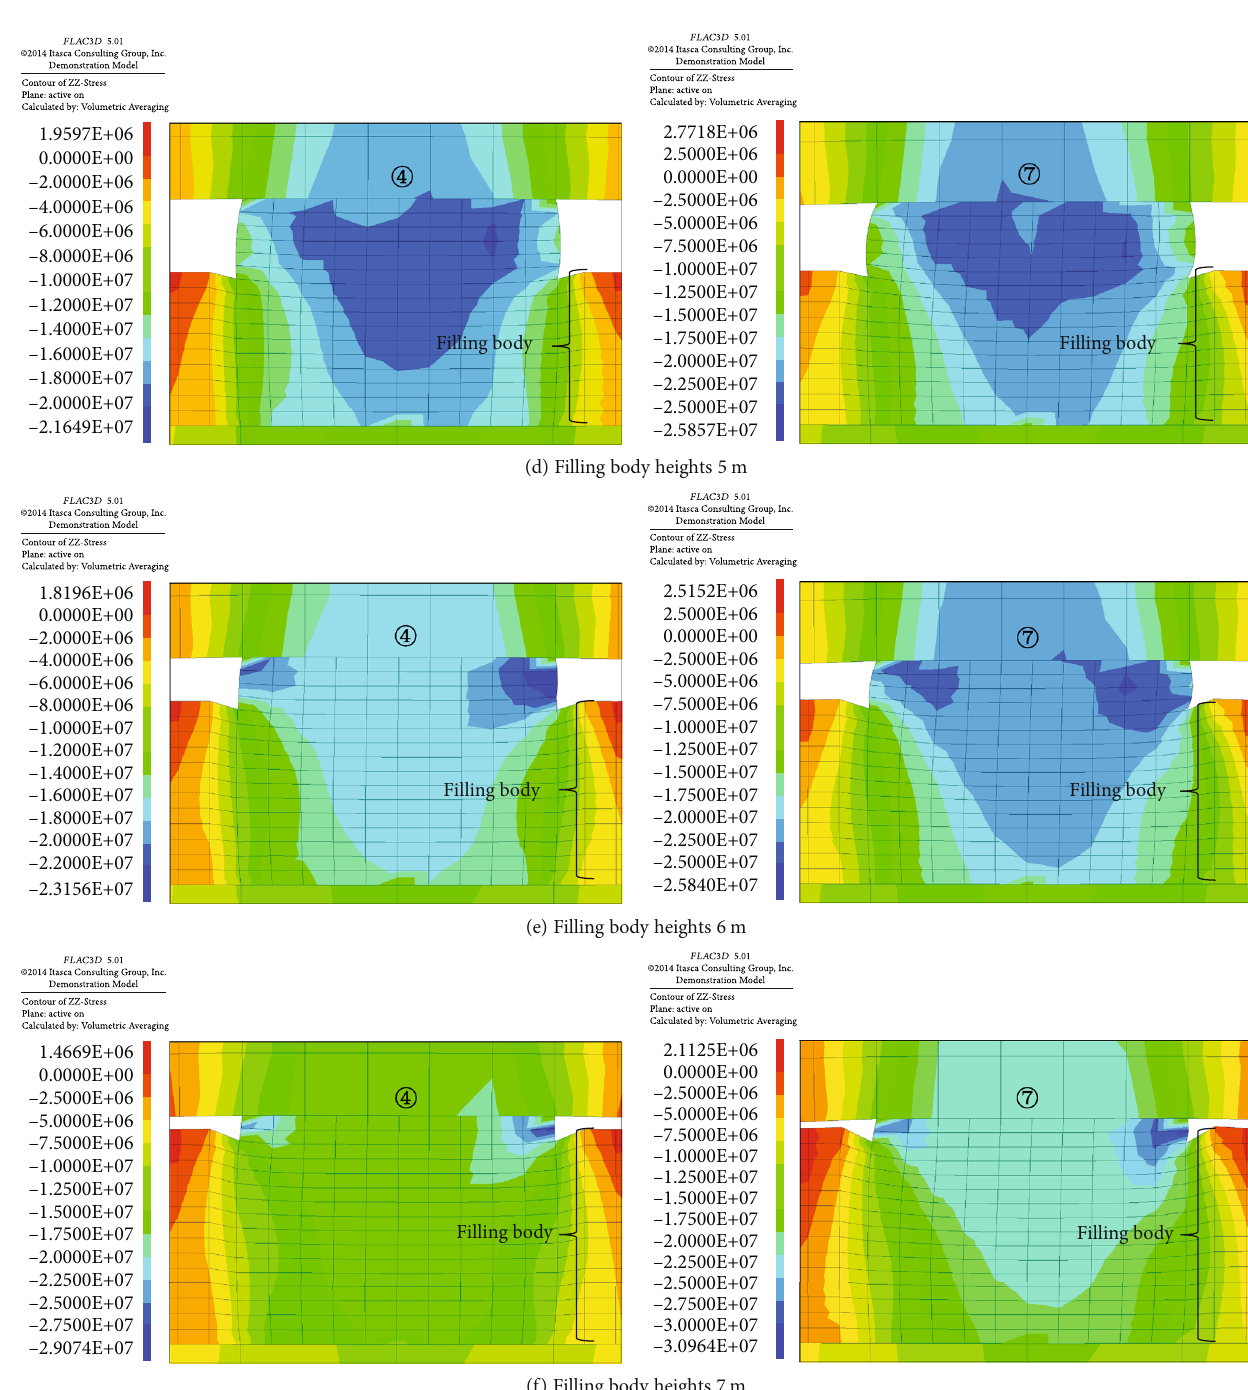
Figure 11: Vertical stress of coal pillars with di ff erent fi lling